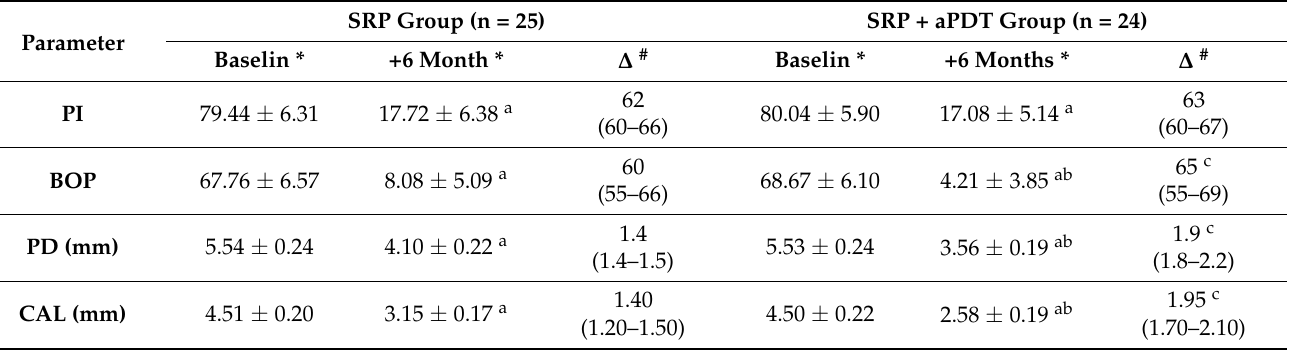
Table 2. Clinical parameters for study groups at baseline and after 6